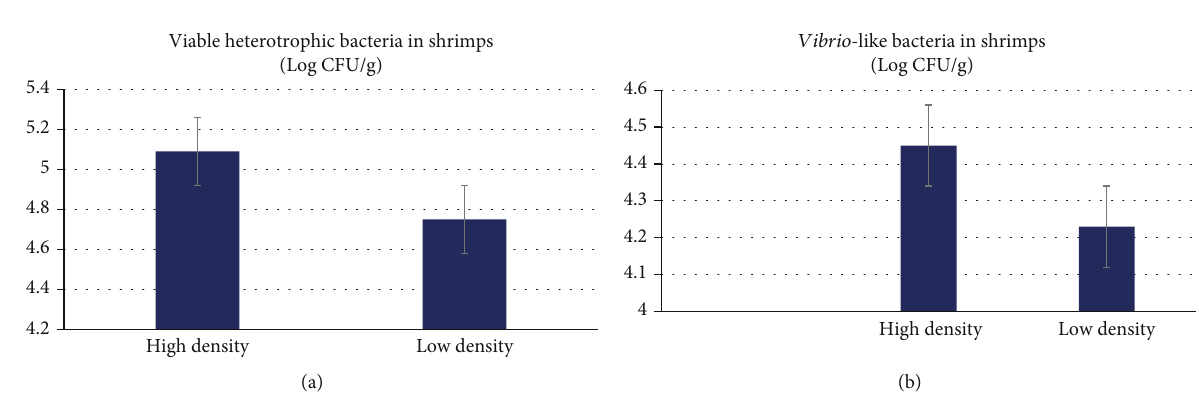
Figure 2: Viable heterotrophic bacteria count (a), and Vibrio -like bacteria count (b) (Log CFU/g) in shrimps ( L. Vannamei ) reared under bio fl oc system in high (300/m 2 ) and low (100/m 2 ) stocking